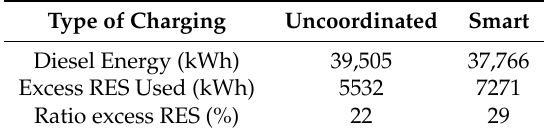
Table 4. Diesel Generation and RES power excess used for charging EV for Scenario 1.